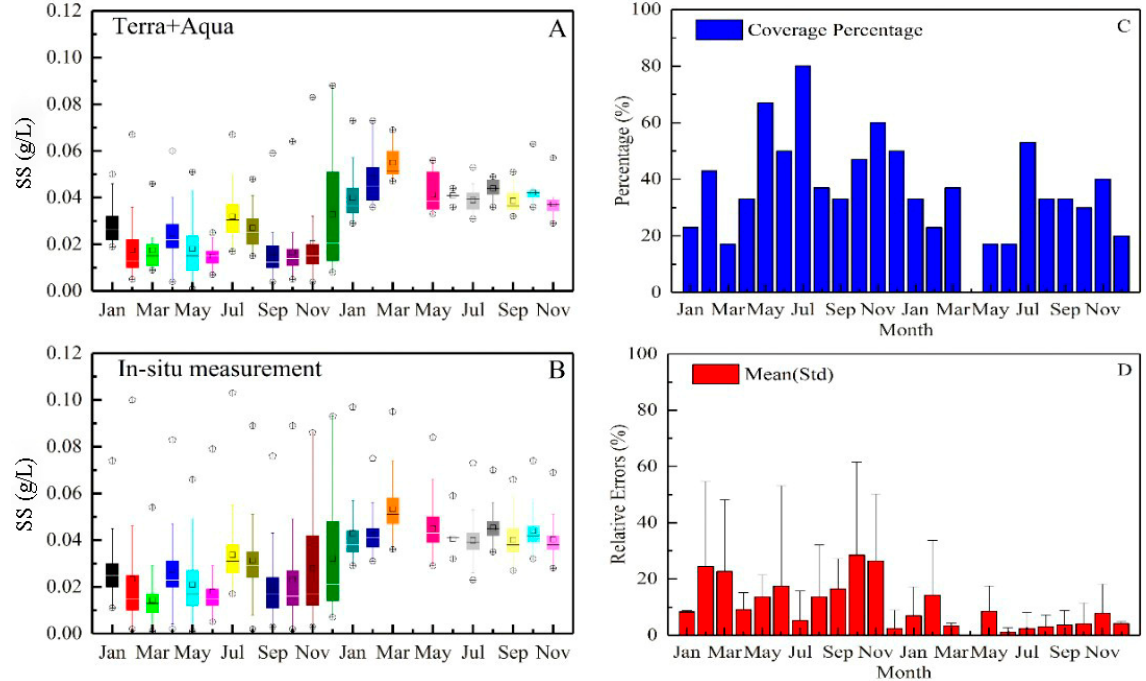
Figure 9. Monthly suspended solids (SS) of valid MODIS observations ( A ), in situ measurements ( B ), monthly coverage of MODIS observations ( C ), and relative errors between MODIS and in situ measurements ( D ).